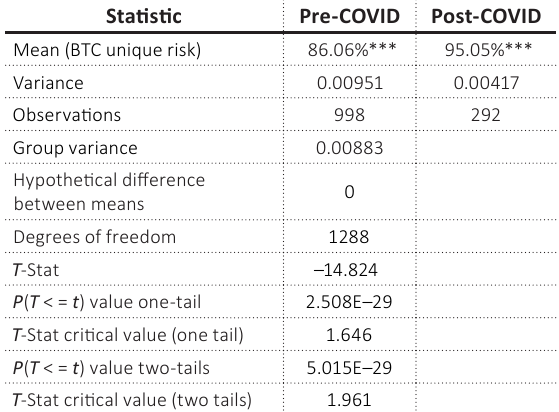
Table 2. T -test for distinctions in unique or idiosyncratic risk of Bitcoin for the pre-COVID-19 period and the post-COVID